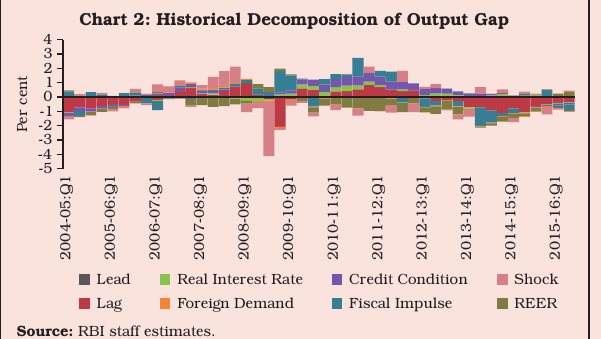
Chart 2: Historical Decomposition of Output Gap